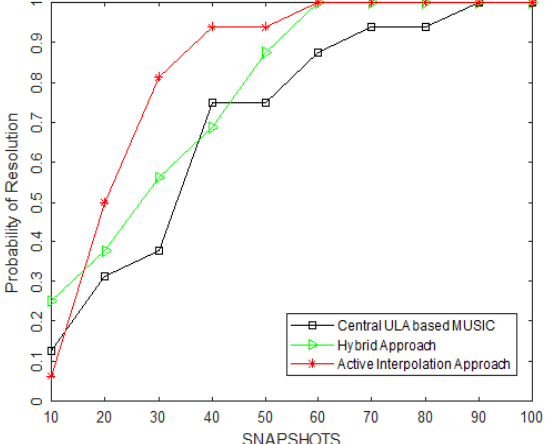
Figure 7. PR versus number of snapshots (SNR = 0 dB, K = 16 sources, I = 300 Monte Carlo Experiments).